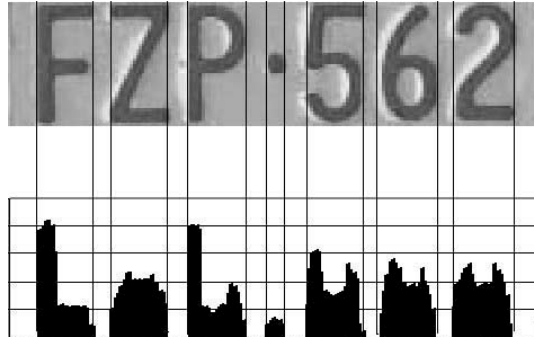
Figure 1 – Histogram of the projections on the x- and y-axes (Nosseir & Roshdy,